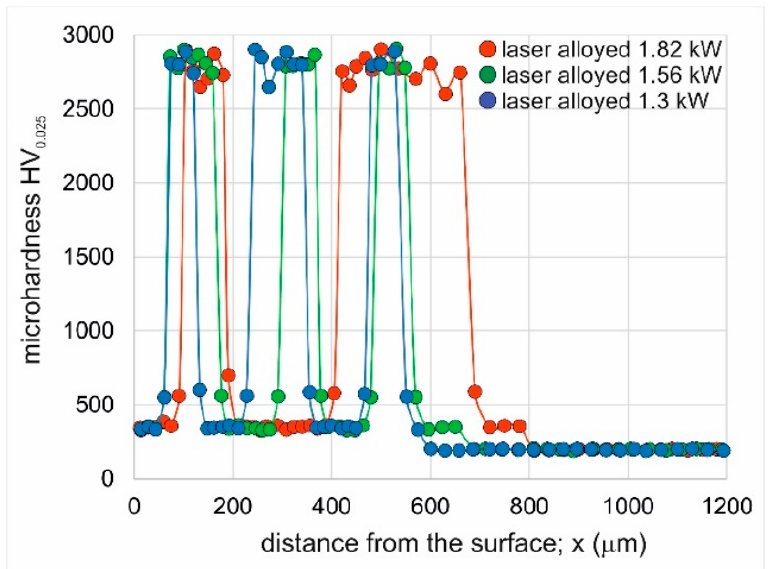
Figure 10. Microhardness profiles of Inconel ® 600-alloy after laser surface alloying with WC particles/Inconel ® 625 using a laser beam power of 1.3 kW, 1.56 kW, and 1.82 kW.